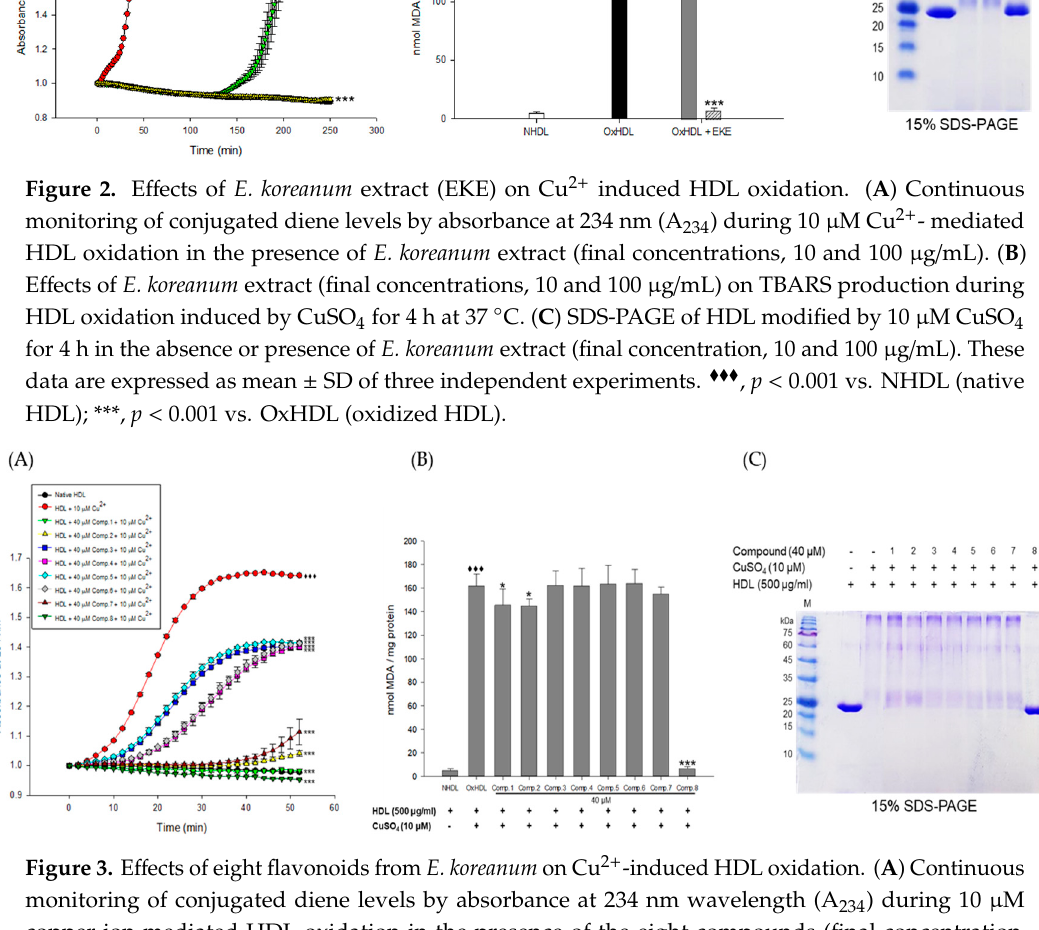
Figure 3. E ff ects of eight flavonoids from E. koreanum on Cu 2 + -induced HDL oxidation. ( A ) Continuous monitoring of conjugated diene levels by absorbance at 234 nm wavelength (A 234 ) during 10 µ M copper ion mediated HDL oxidation in the presence of the eight compounds (final concentration, 40 µ M). ( B ) E ff ect of the eight flavonoids (final concentration, 40 µ M) in TBARS production during HDL oxidation induced by CuSO 4 for 4 h at 37 ◦ C. ( C ) SDS-PAGE showing HDL modified by 10 µ M CuSO 4 for 4 h in the absence or presence of the eight flavonoids (final concentration, 40 µ M). These data are expressed as mean ± SD of three independent experiments. (cid:7)(cid:7)(cid:7) , p < 0.001 vs. NHDL (native HDL); *, p < 0.01; ***, p < 0.001 vs. OxHDL (oxidized